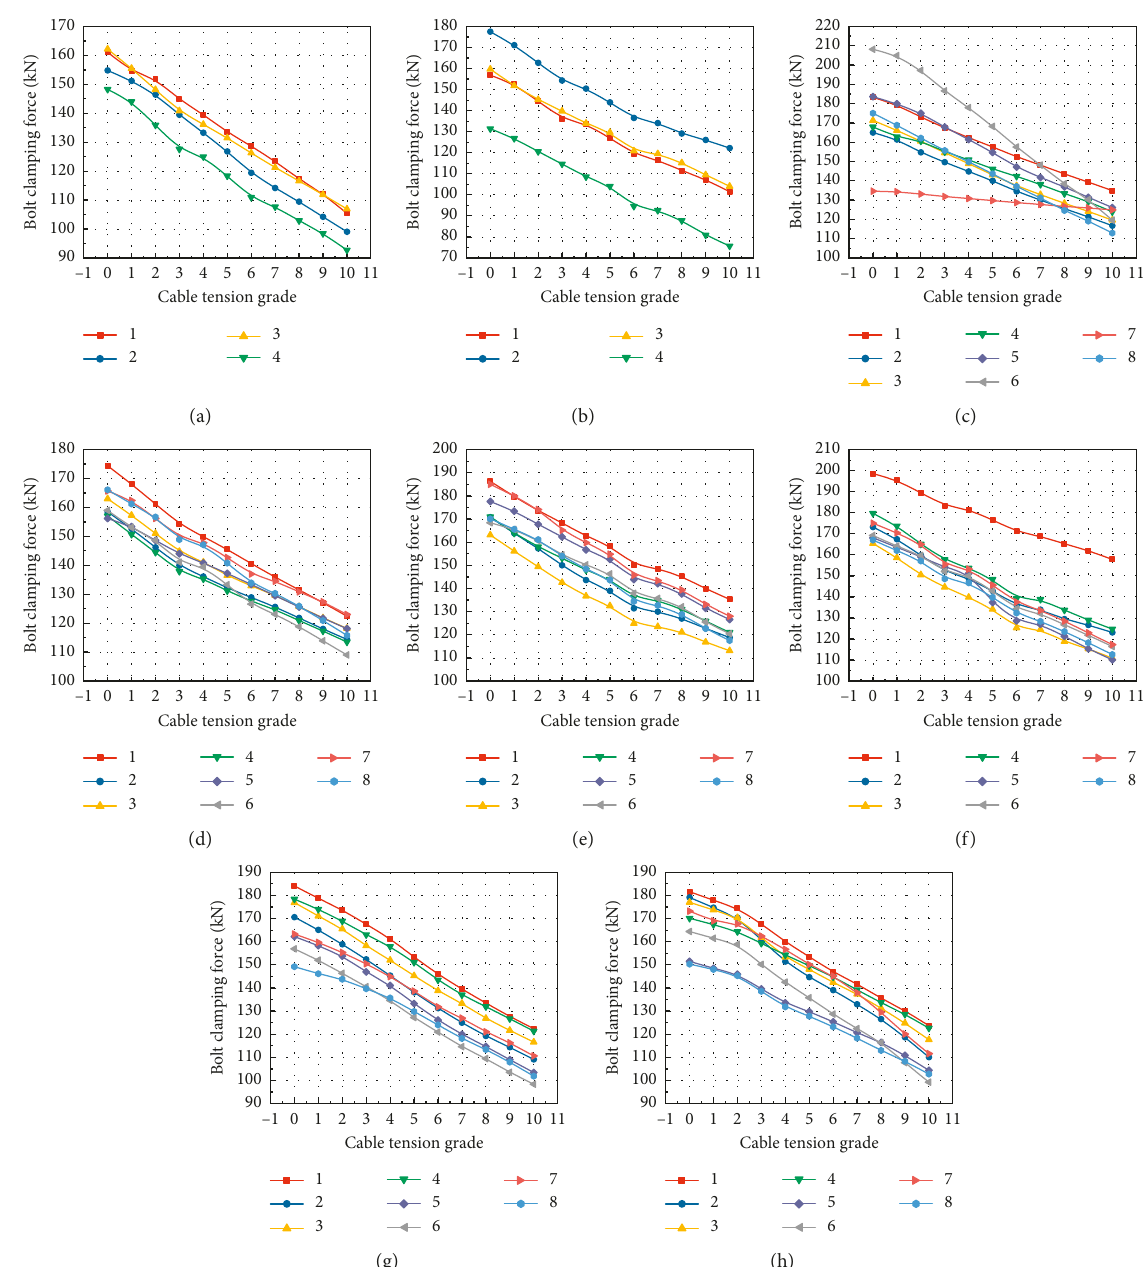
Figure 18: Reduction in bolt clamping force during cable tensioning. (a) Table 6: Comparison of theoretical and actual values of the reduction in bolt clamping force with cable tension. Poisson’s ratio of cables Equivalent elastic modulus (MPa) Specimen